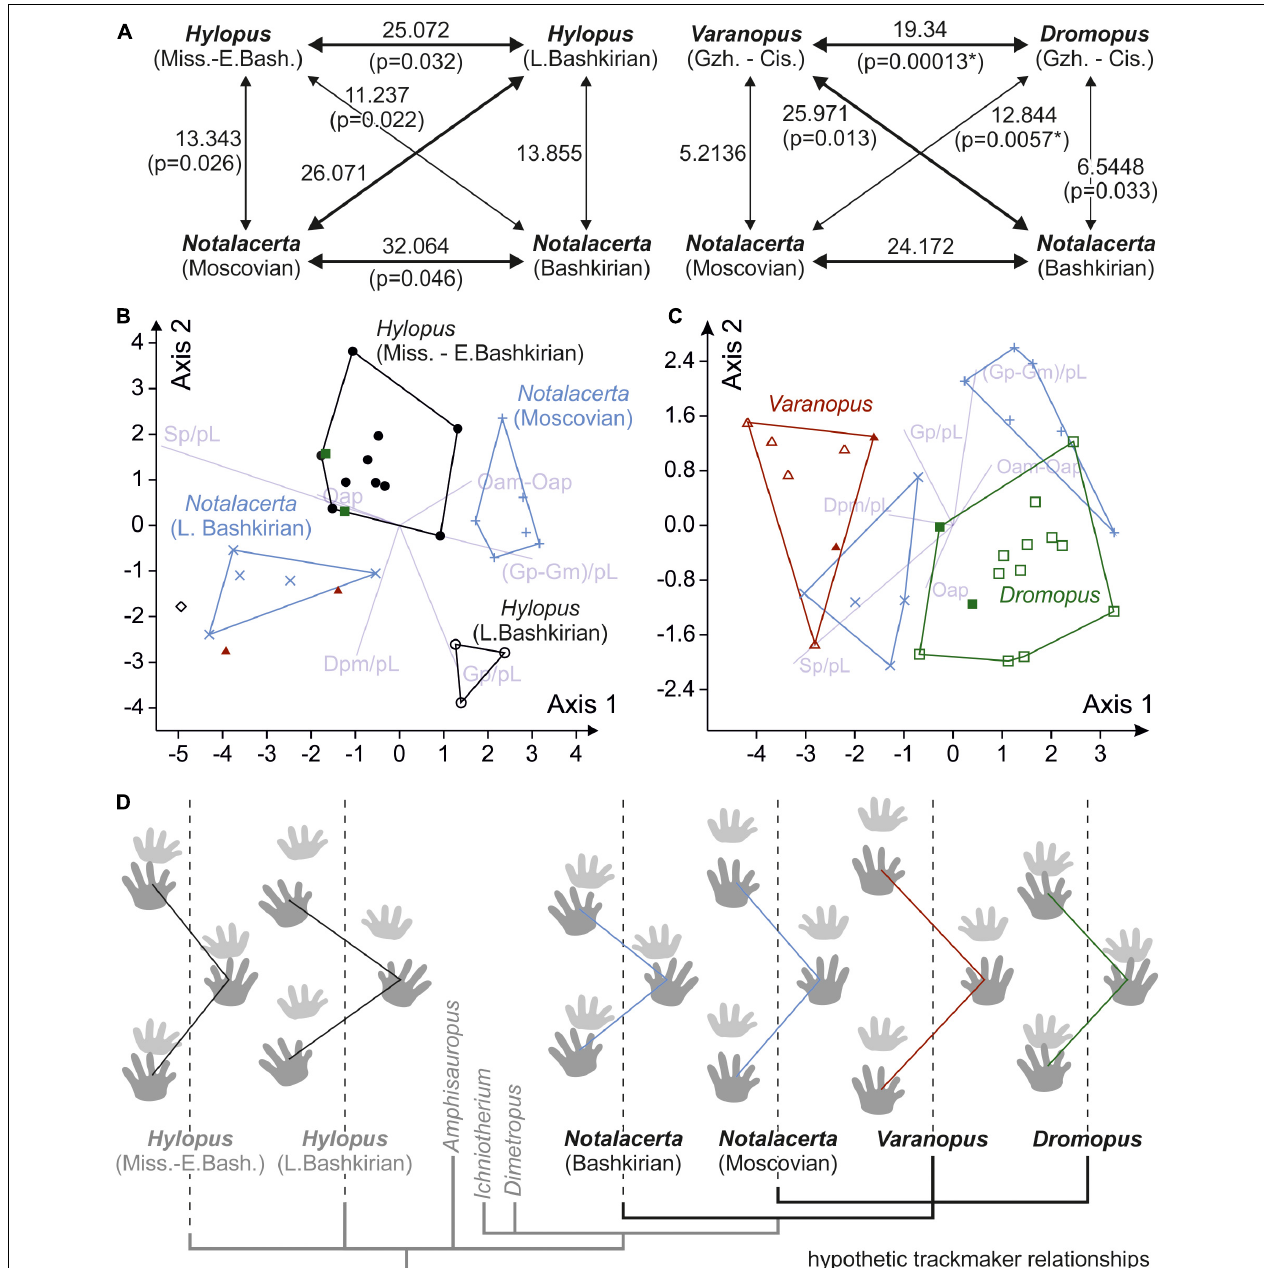
FIGURE 10 | Results of multivariate analyses and visualization of average trackway patterns for the different groups considered in these analyses. (A) Visualization of MANOVA pairwise test results for two test cases (4 groups, 6 trackway measures). The numbers represent squared Mahalanobis distances between samples. Bold arrows indicate higher distance values; p -values that signal significant differences between groups ( < 0.05 are after Bonferroni correction) are marked with an asterisk. (B) Biplot depicting the axes of highest discrimination according to an LDA of Hylopus and Notalacerta groups. (C) Biplot depicting the axes of highest discrimination according to an LDA including Notalacerta and Cisuralian samples of Dromopus and Varanopus . The symbols used in the diagrams are the same as in Figure 9 . (D) Average trackway patterns for six groups of trackways and tree scheme depicting a hypothesis for the phylogenetic relationships of the supposed trackmakers in a simplified way. Notice that the illustrated tracks are not representative of the ichnotaxa morphology but are only a reference for the trackway pattern.